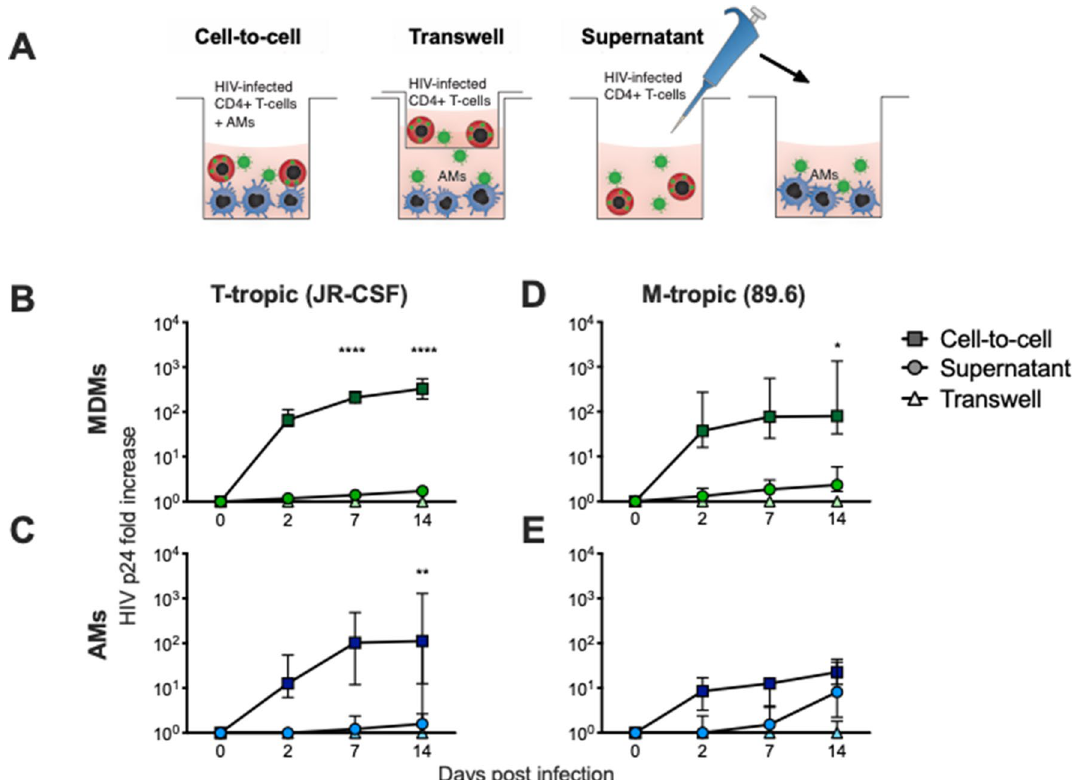
Figure 3. T-tropic HIV infection is more efficient through cell-to-cell than through cell-free transmission to MDMs and AMs. ( A ) MDMs were matured for 7 days or AMs were adhered for 1 h. CD4+ T cells were activated with PHA for 3 days, infected with HIV JR-CSF or 89.6 at a MOI of 0.2 overnight, washed, and cultured for 4 days, when approximately 10% of T cells were HIV Gag+ by flow cytometry. After the T cells were centrifuged, the supernatant from CD4+ T cells was used for the SN condition. The pellet of CD4+ T cells was resuspended and added directly (CTC) or across a transwell (TW) for 3 h and washed, using a ratio of 1:1 T cell:macrophage. ( B – E ) Supernatants from ( B , D ) MDMs or ( C , E ) AMs were collected and HIV p24 was measured by ELISA. p value shows the value for cell-to-cell vs. supernatant conditions at the given timepoint using a two-way ANOVA with Tukey’s multiple comparisons test; n = 6 for MDMs and AMs. * p < 0.05, ** p < 0.01, **** p <